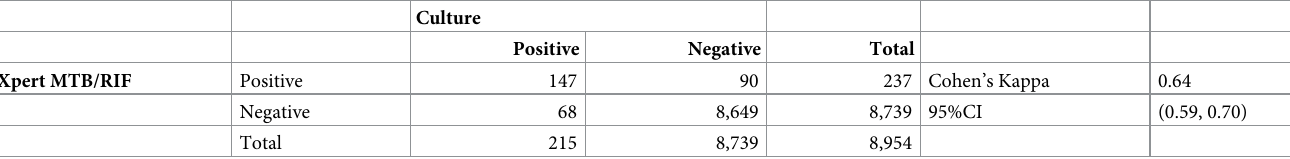
Table 8. Tthe level of agreement between Xpert MTB/RIF and culture in TB